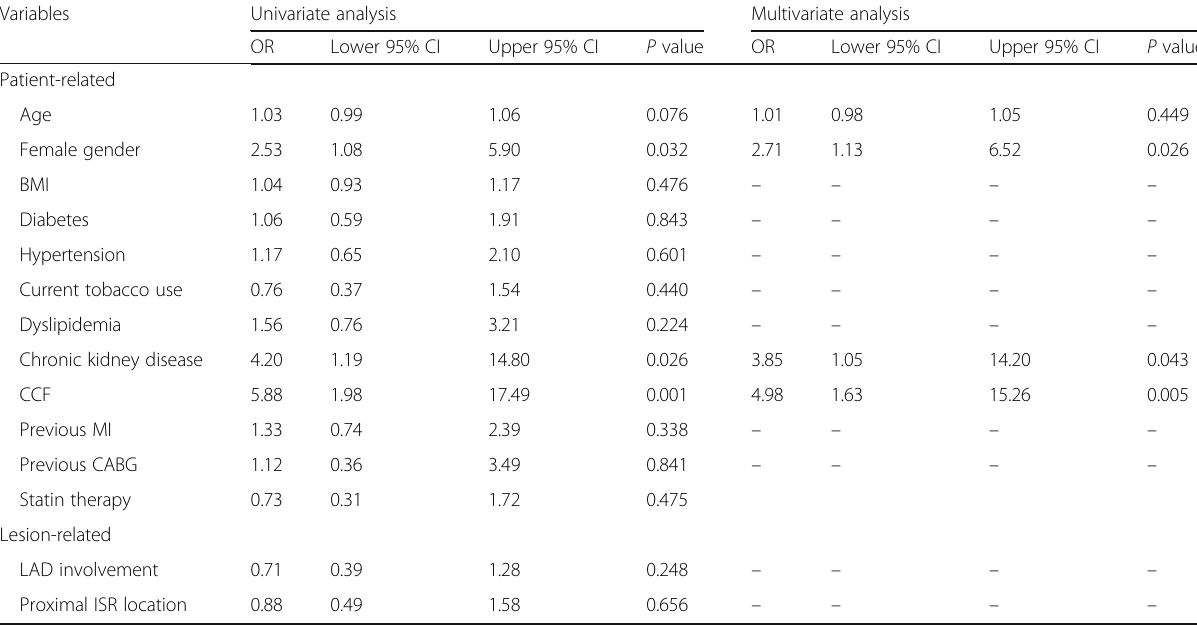
Table 3 Correlates of ACS ISR presentation compared to non-ACS presentation Variables